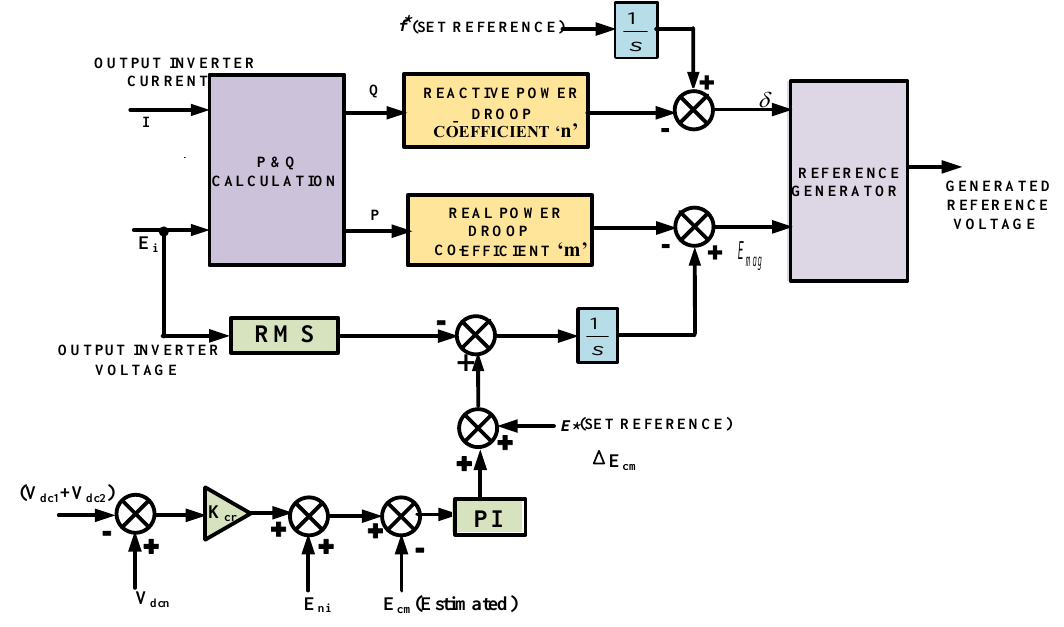
Figure 4. The proposed reinforced droop control.